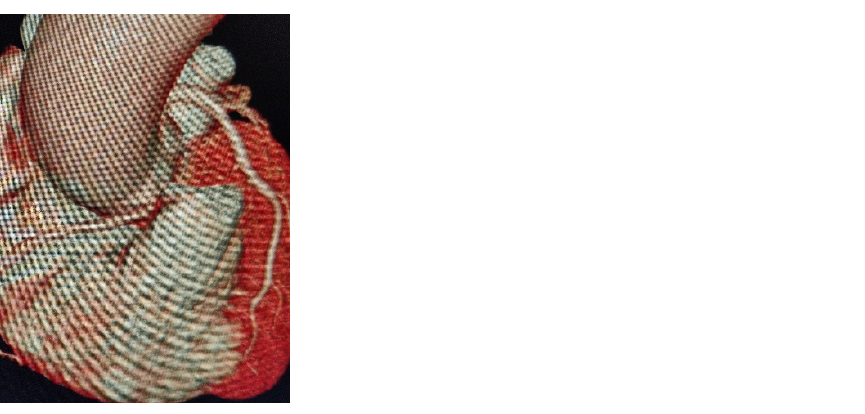
Figure 1. 3D computed tomography (CT) volumetric visualization of inter-arterial course of right coronary artery.